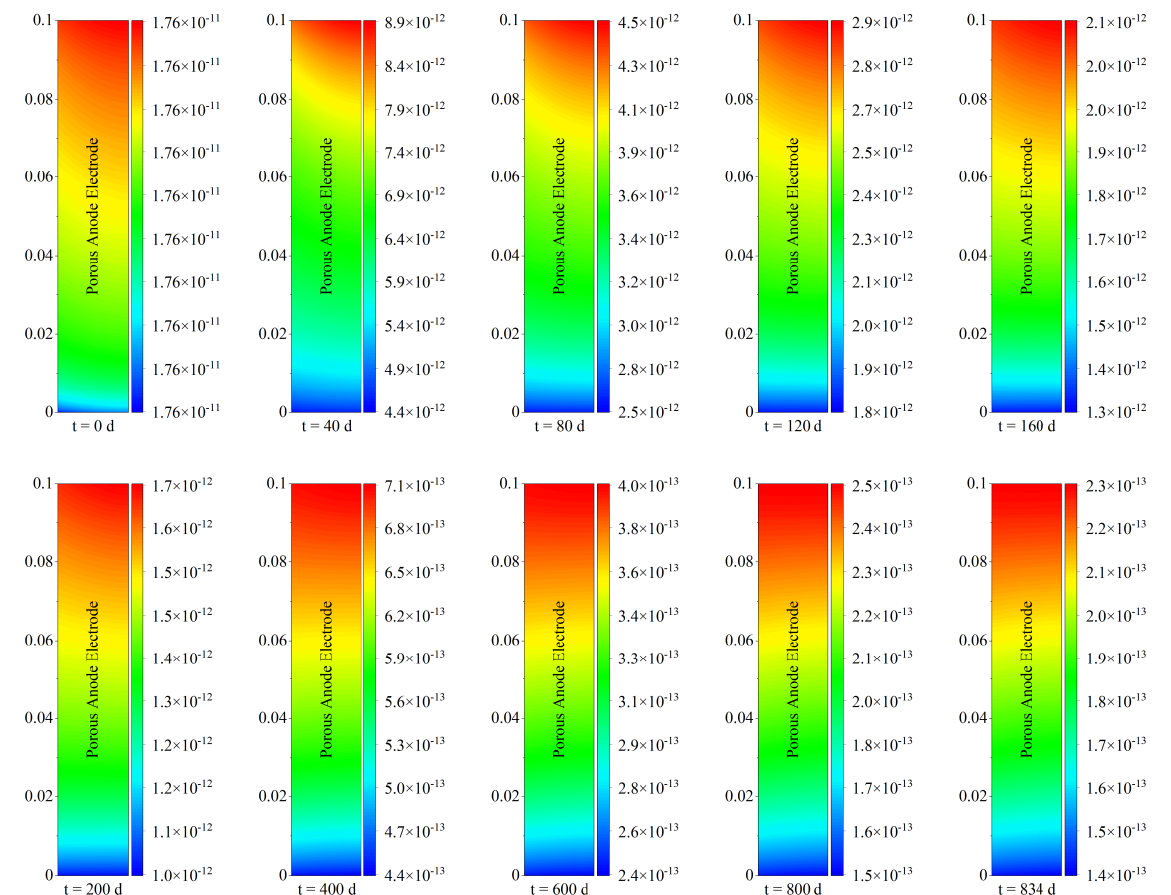
Figure 7. The spatial and temporal evolution of permeability (m 2 ) within the porous anode electrode of the solid oxide fuel cell during 20,000 h of steady − state operation.